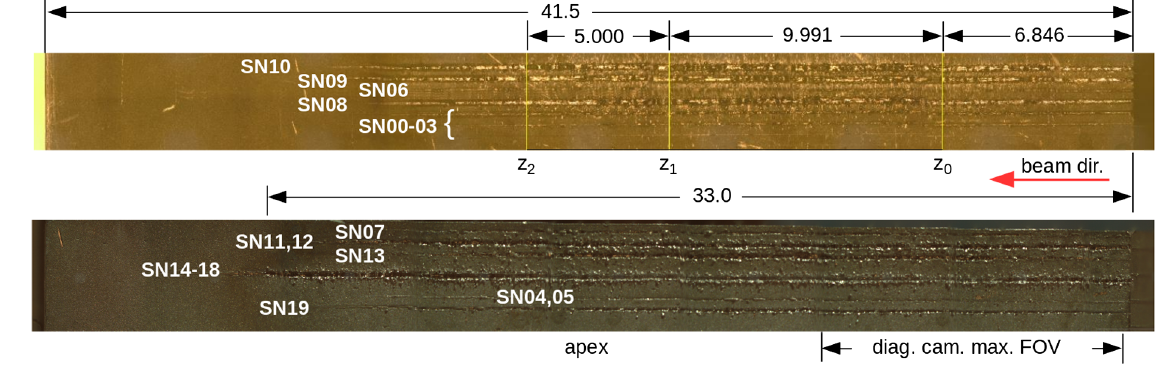
FIG. 24. Overview of the top and bottom collimator test pieces struck by beam dumps recorded at 25 × magnification. The top piece was subjected to single-strike beam dumps; the bottom piece received both single and multiple beam dumps at the same vertical offsets. Beam was moving from right to left. Three z locations of interest are indicated on the top image; the apex location is just upstream of the z 2 position. All dimensions are in mm.